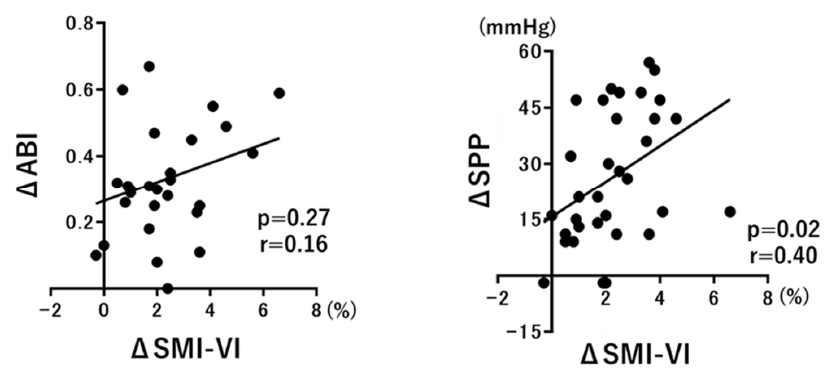
Figure 4. Correlations of ∆ SMI-VI with ∆ ABI and ∆ SPP.